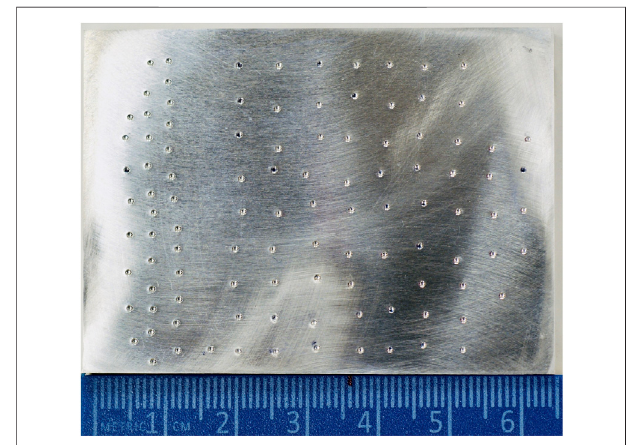
FIGURE 3 | A picture of the sample after indentation measurements were taken. Indentations in excess of 99 were discarded due to loss of data.